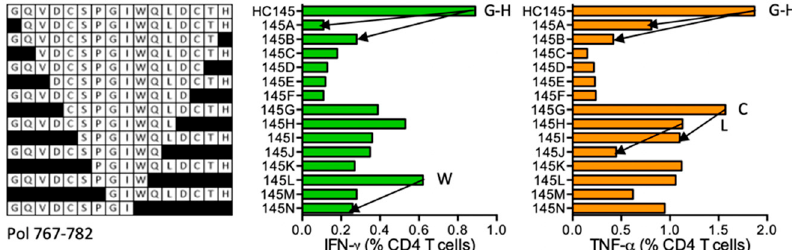
Figure 15. HC145 / VID 404—definition of CD4 + T-cell epitopes in HIV-1 protein Pol. HC145-expanded SCTL of volunteer 404 was stimulated in an ICS assay using truncated peptides (left) and CD4 + T cell frequencies producing IFN- γ (green) and TNF- α (orange) were determined using flow cytometry. Arrows and amino acids G, H, W, C and L indicate the stimulatory peptide termini. HC164 VQMAVFIHNFKRKGGI (Pol